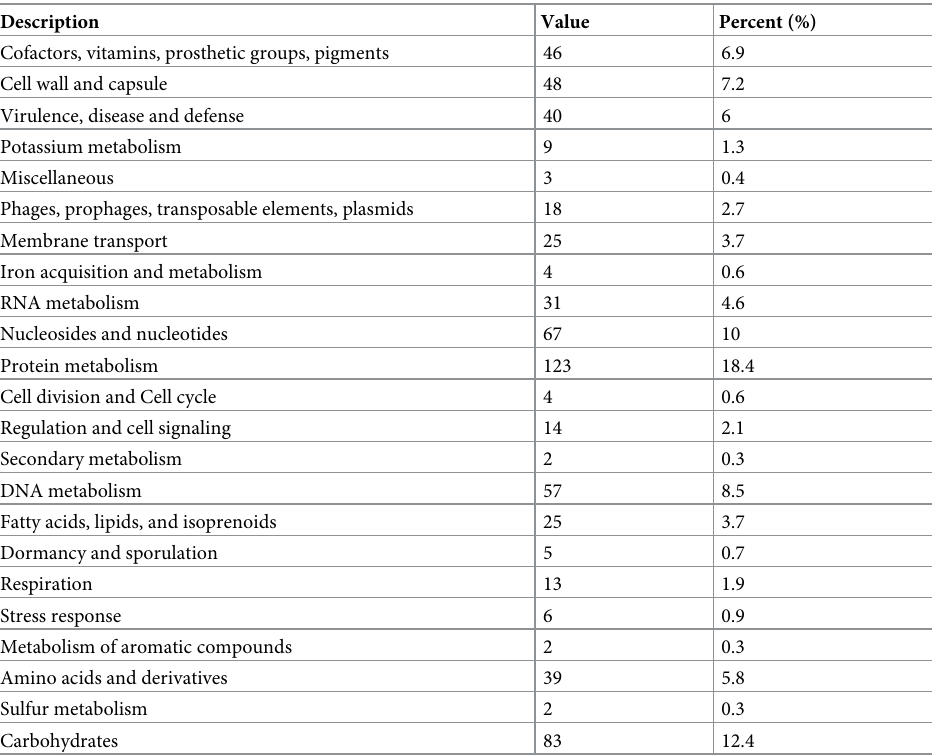
Table 3. General overview of biological subsystem distribution of the annotated genes.